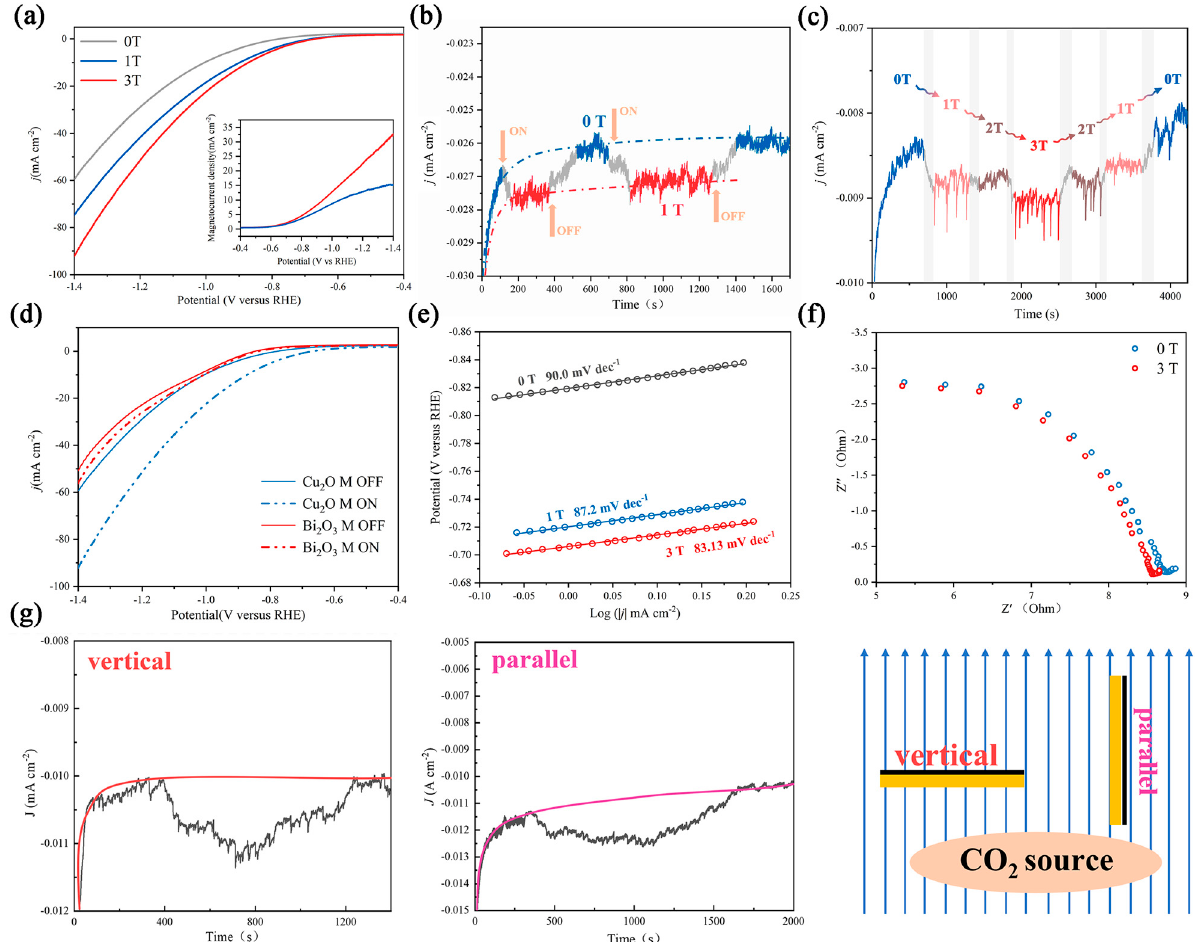
Figure 2. Electrochemical characterization of the catalyst under different magnetic fields. ( a ) LSV curves and magnetocurrent curves under 0 T, 1 T, and 3 T magnetic fields. ( b ) Plot of current density vs. time in a 1 T intermittent magnetic field; the yellow arrow corresponds to the switching time. ( c ) Plot of current density vs. time in a magnetic field; the gray area corresponds to the interim time. ( d ) LSV curves of Cu 2 O and Bi 2 O 3 with/without a magnetic field. ( e ) Tafel slope of Cu 2 O under different magnetic fields. ( f ) EIS plot of Cu 2 O under 0 and 3 T magnetic fields. ( g ) Plot of current density vs. time in vertical and parallel orientations toward the magnetic sensing line.